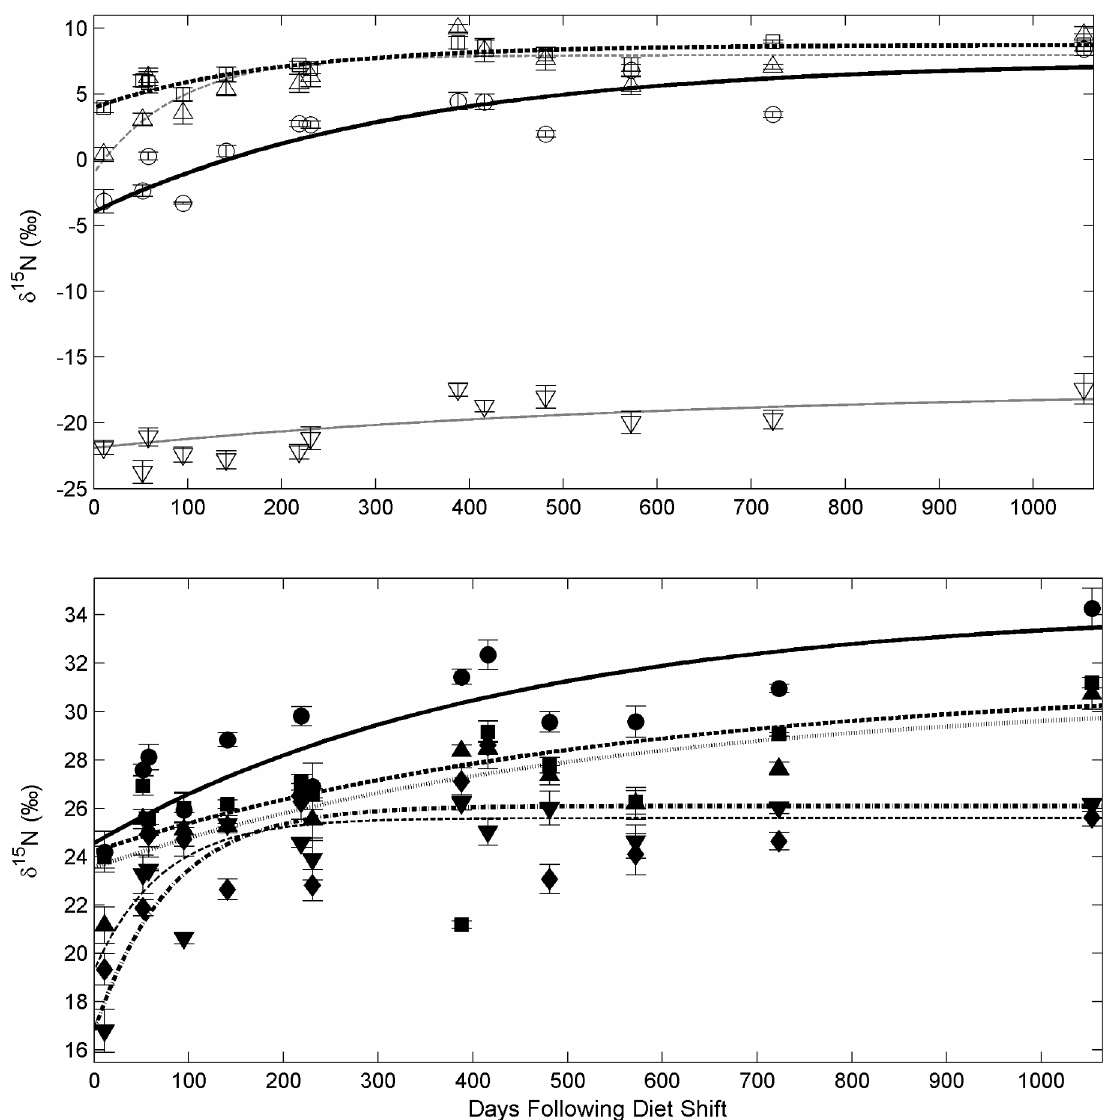
Figure 1. Change in amino acid d 15 N values in white muscle in captive Pacific bluefin tuna ( Thunnusorientalis ). Isotopic change over time following a diet shift in A) four source amino acids - glycine (open circle), lysine (open square), serine (open triangle), threonine (open inverted triangle), and B) five trophic amino acids - alanine (filled circle), glutamic acid (filled square), leucine (filled triangle), proline (filled inverted triangle), and valine (unfilled diamond) in Pacific bluefin tuna white muscle tissue. Lines represent best fit lines for an exponential fit